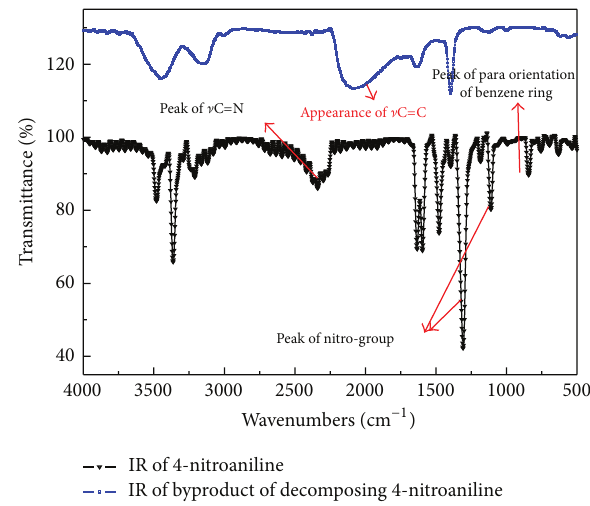
Figure 7: The infrared spectrometer on byproduct after finishing degradation of the